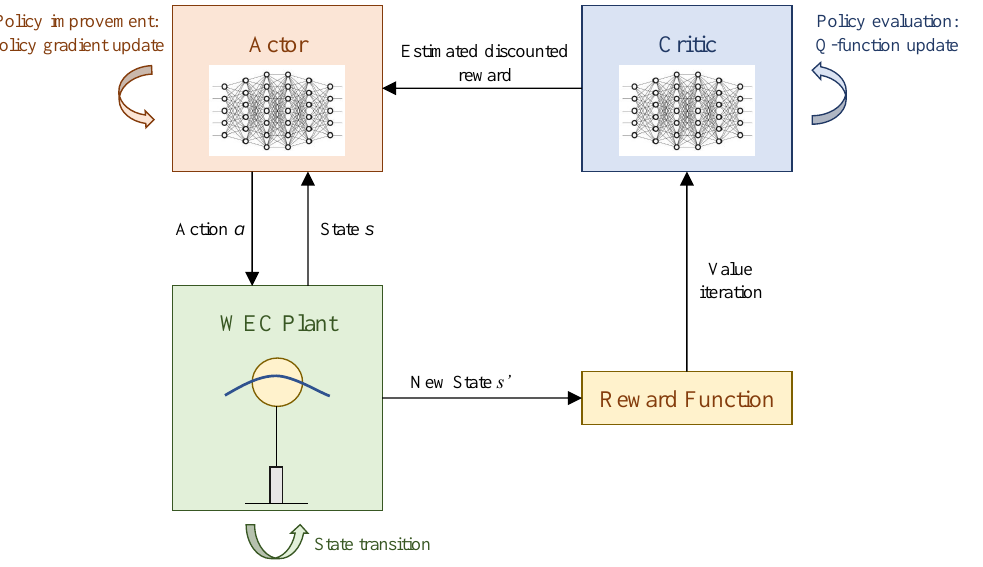
Figure 3. Diagram of the soft actor-critic (SAC) algorithm for the real-time control of a wave energy converter